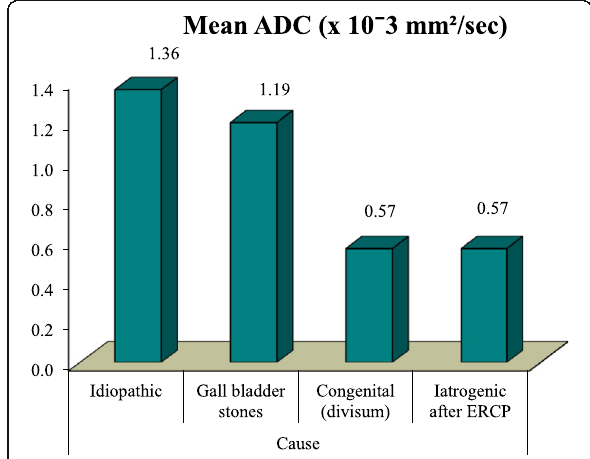
Fig. 1 Relationship between causes and mean ADC value